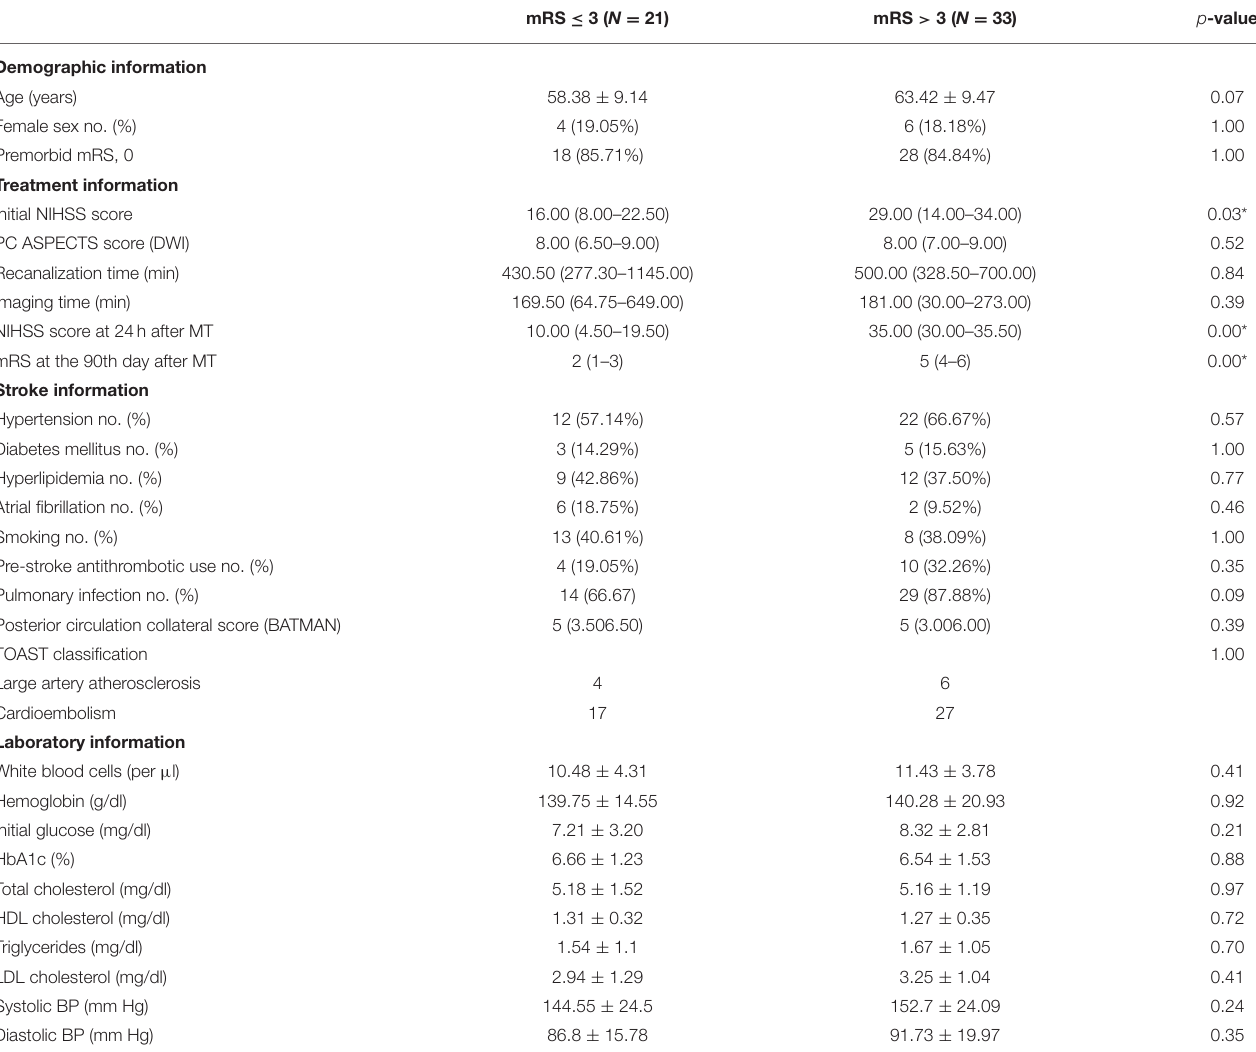
TABLE 1 | Demographic characteristics of enrolled